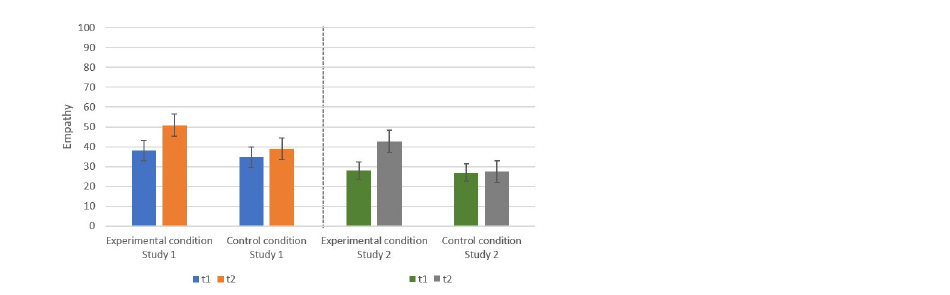
Fig 2. Significant interaction effects between time of measurement and condition regarding empathy. Confidence intervals are represented by the error bars attached to each column.